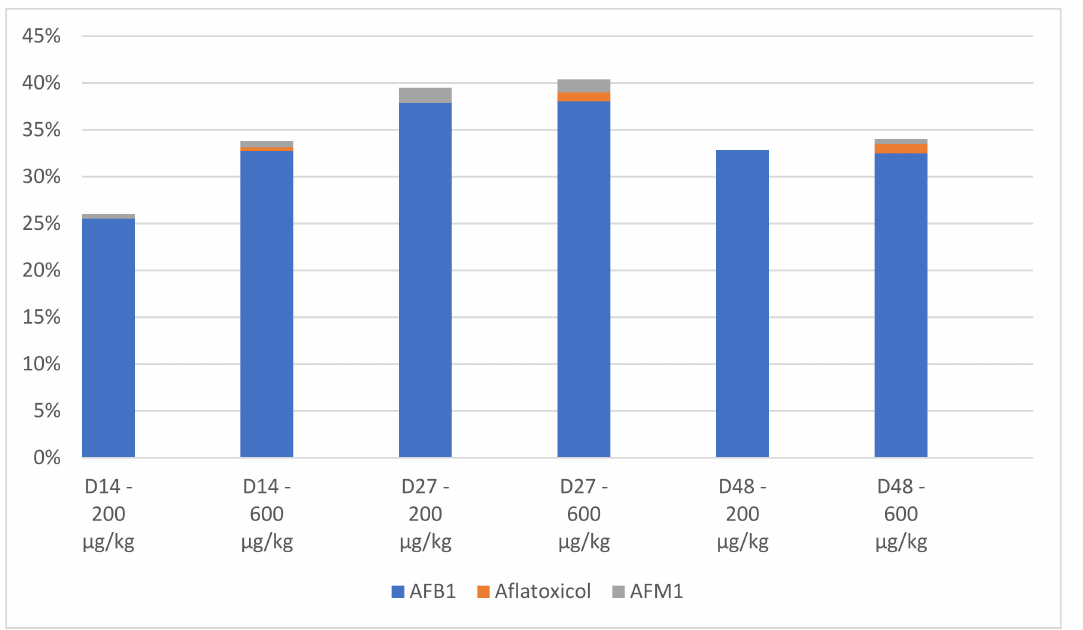
Figure 2. Concentration of aflatoxin B1 (AfB1), aflatoxicol and aflatoxin M1 (AfM1) in the frass, as a percentage of the analyzed concentration in the diet per treatment and collection